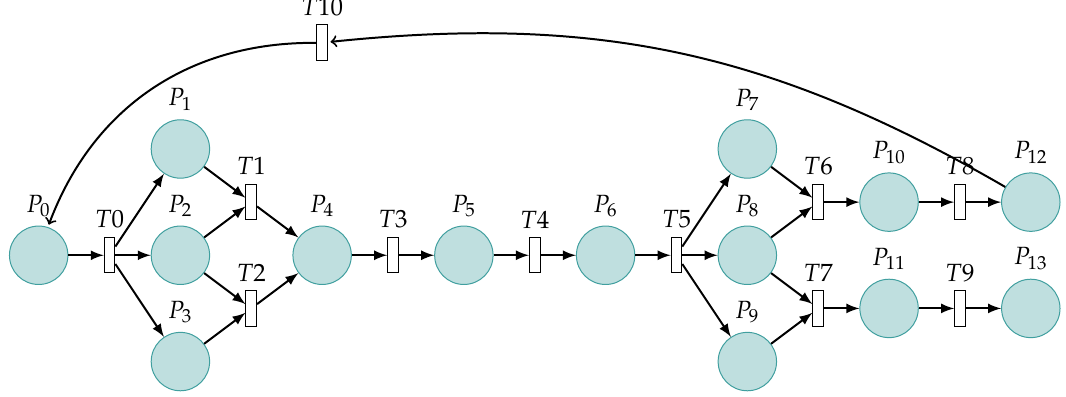
Figure 1. Petri net model of a vulnerability with CVE-2021-3711. Table 1. The meaning of